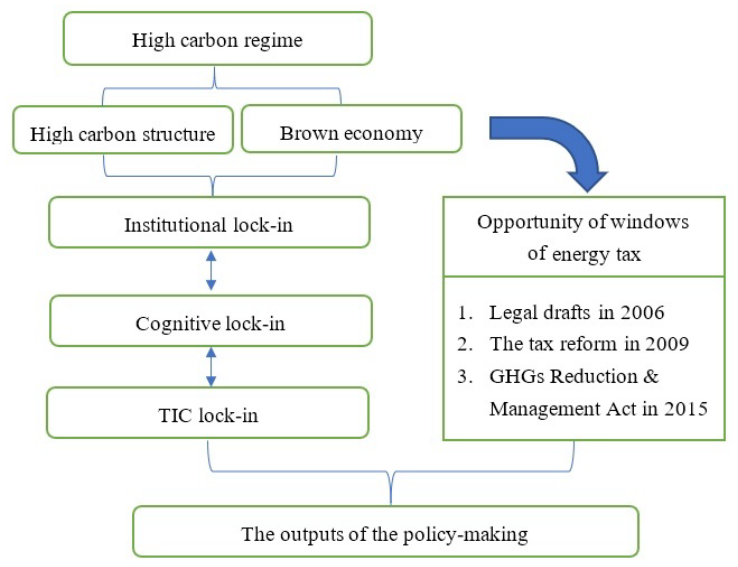
Figure 1. The three windows of opportunity that were undermined by the high-carbon economic and political regime of Taiwan. Source: made by